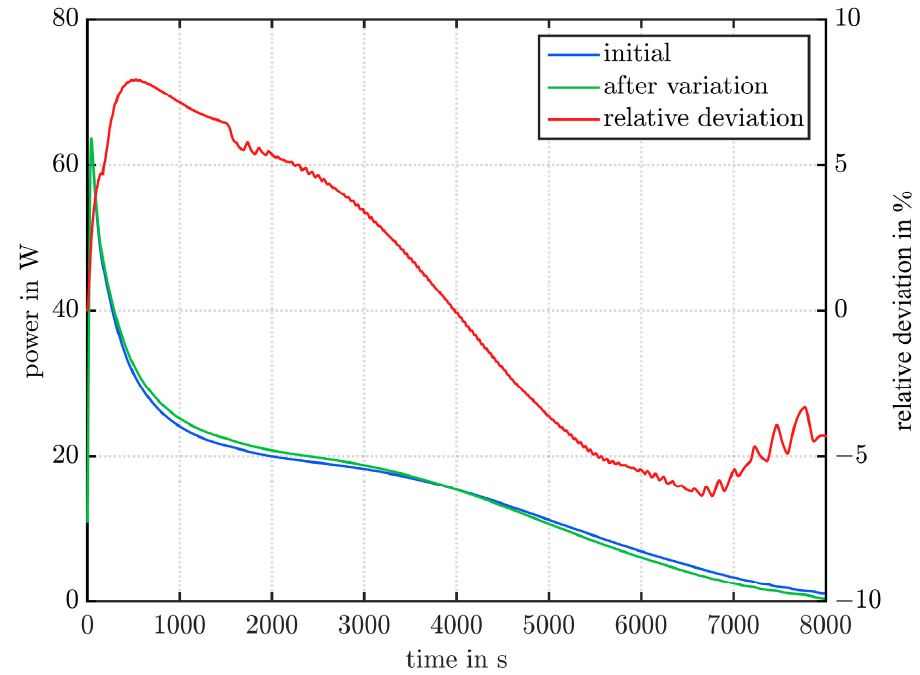
Figure 10. Power over time curve for charging of the standard case and the case with an increased heat conductivity as well as the regarding relative deviation.